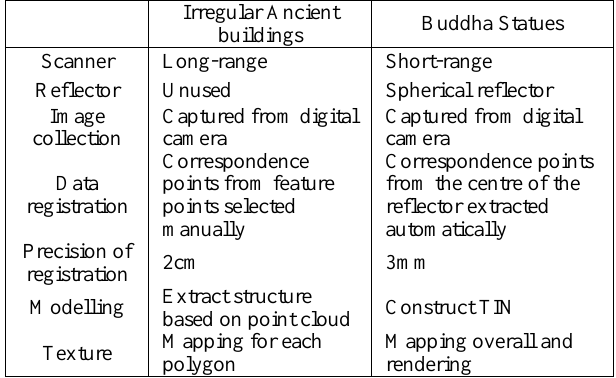
Table 2. Comparison of two solutions of 3D reconstruction to irregular ancient buildings and